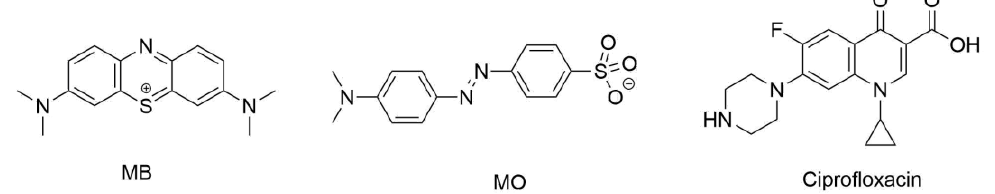
Figure 10. Small molecule cargos for release: Methylene blue (MB), methyl orange (MO), and ciprof- loxacin.